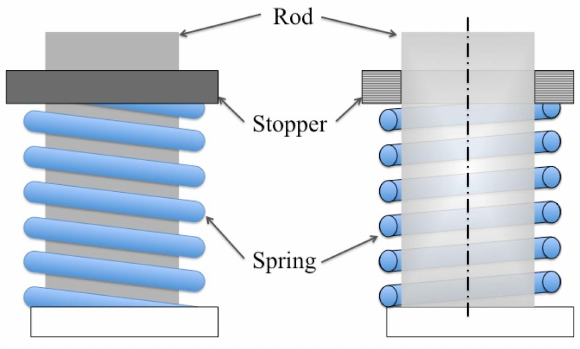
Figure 8. The model of spring mechanism with the